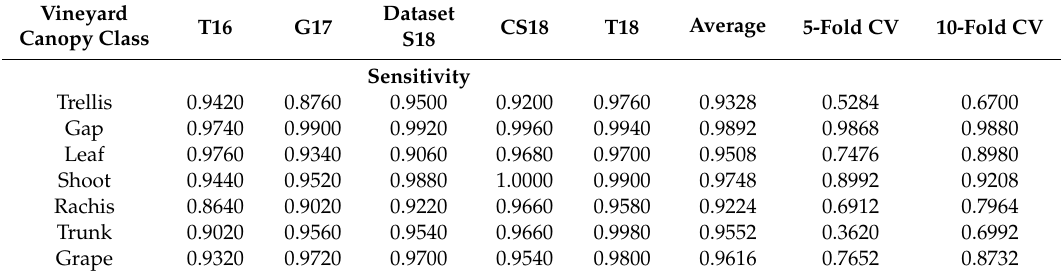
Table 2. Performance results of each multinomial logistic regression model for segmenting images in their respective dataset using a 10-fold stratified cross validation on the manually labeled pixel sets in terms of sensitivity, specificity, F1 score, area under the receiver operating characteristic (ROC) curve (AUC) and intersect over union (IoU) metrics. Their average was compared with the performance of a single segmentation with all datasets combined using a 5-fold and a 10-fold stratified cross